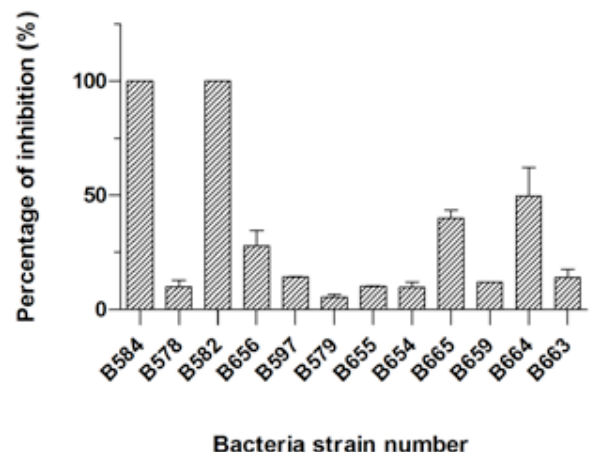
Figure 1. In vivo screening of bacterial antagonists against Botrytis cinerea. The percentage of inhibition is given after 7 days. The error bars represent the mean + SE of three replicates.